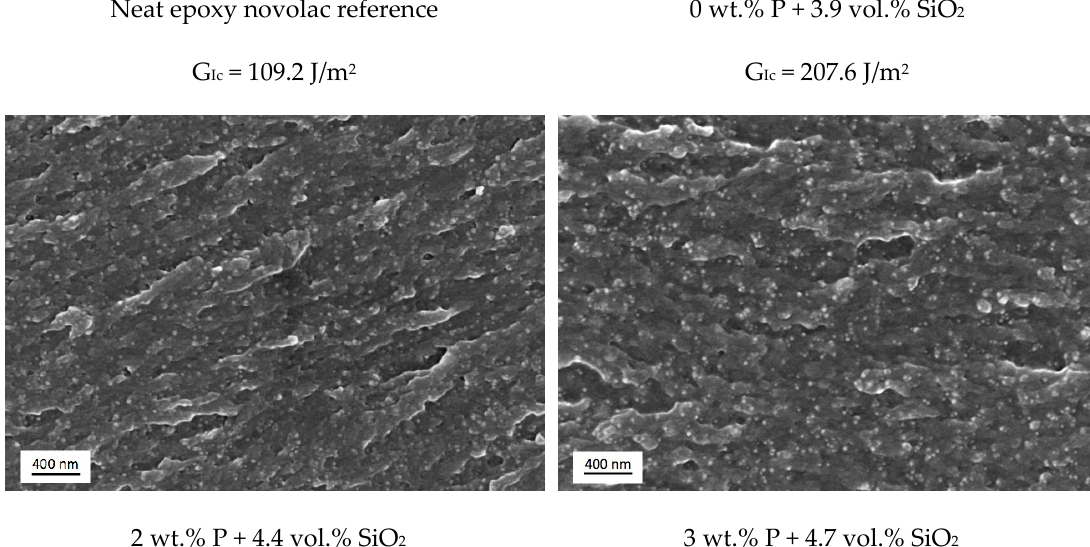
Figure 8. SEM images of K Ic -fracture surface of neat novolac (up left), novolac + 3.9 vol.% SiO 2 (up right) novolac + 2 wt.% phosphorous + 4.4 vol.% SiO 2 (down left) and novolac + 3 wt.% phosphorous + 4.7 vol.% SiO 2 (down right). Crack propagation direction: left to right.